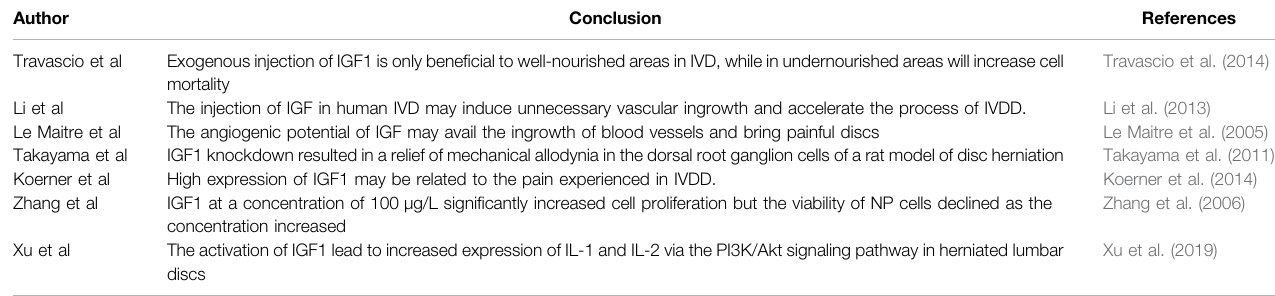
TABLE 2 | Abnormal activation of IGF signaling aggravates IVDD.